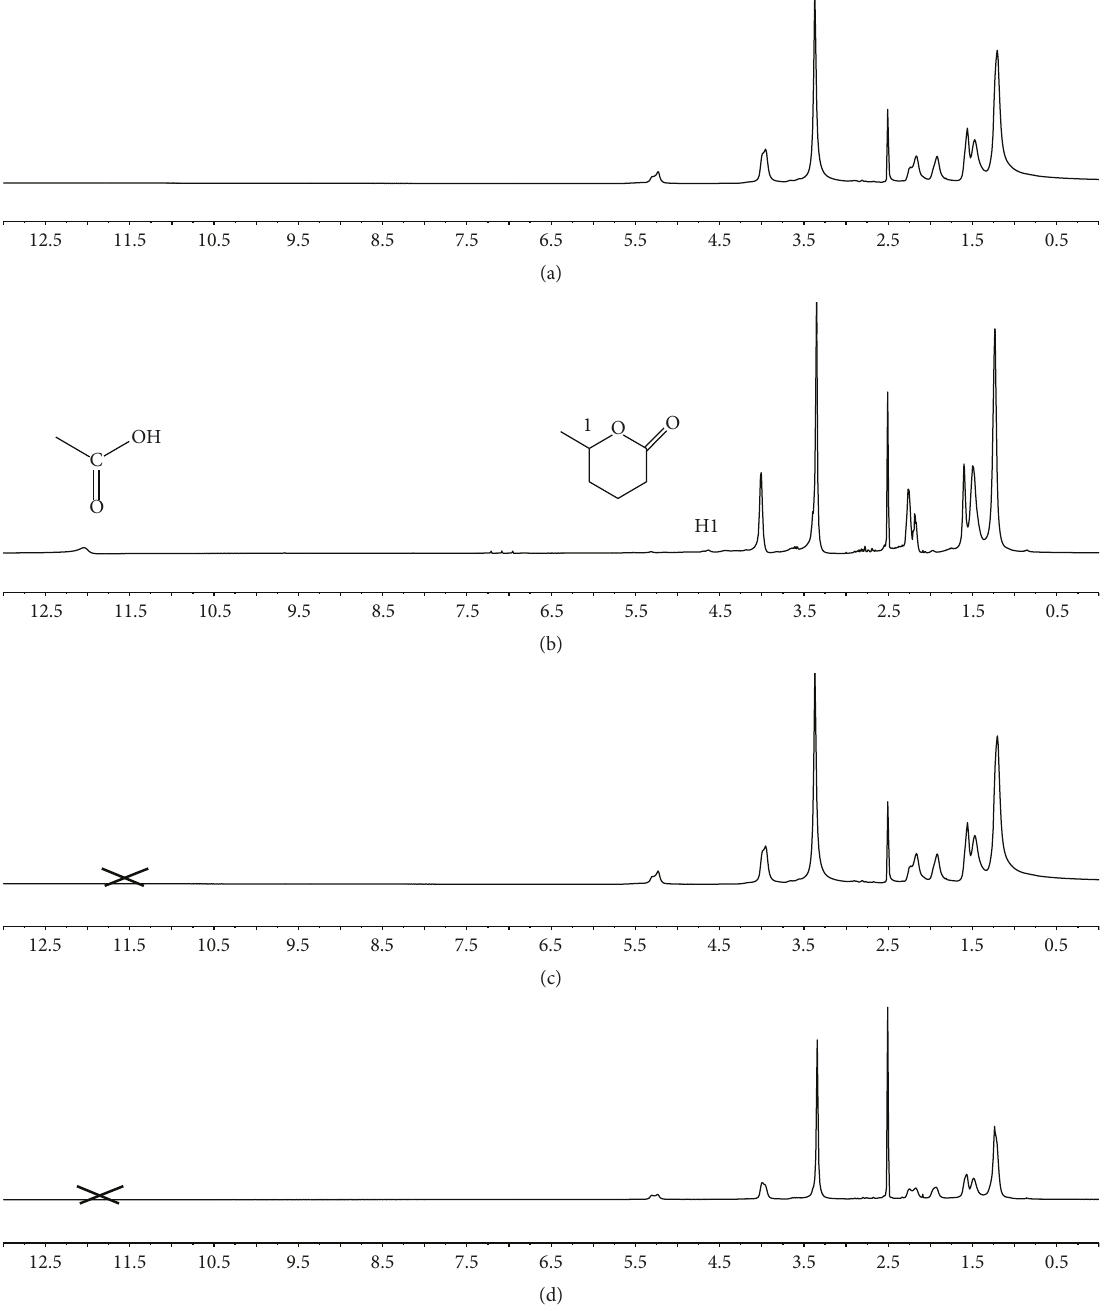
Figure 18: 1 H NMR spectrum of degraded sample PBC18 ( pH = 4 35 ) at 37 ° C; (c) degraded sample in water ( pH = 7 4 ) at 37 ° C, degraded sample in water ( pH = 18 5 ) at 37 °